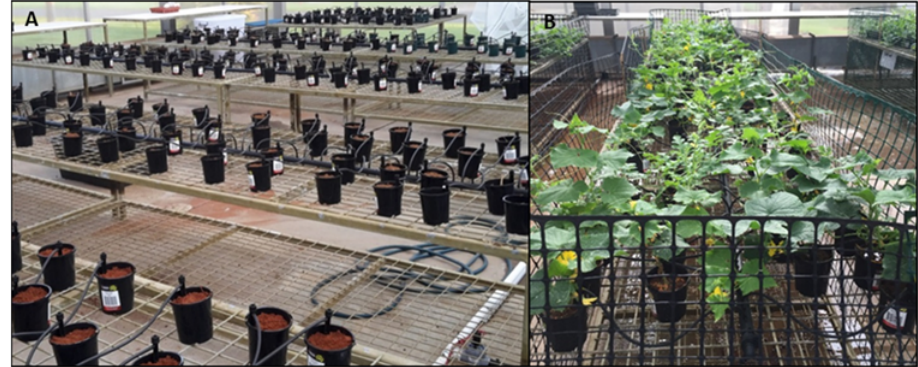
Figure 5. Setup of the soil longevity trial conducted in an insect proof screenhouse at Berrimah Farm Research Station. ( A ) Pre-planting; ( B ) Post Planting.